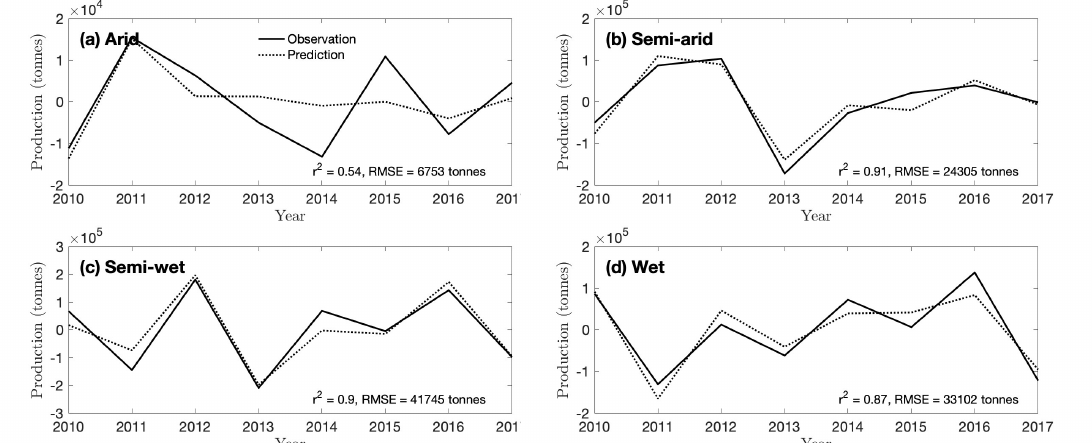
Figure 5. Observations and predictions of rice production anomalies (tonnes) in the ( a ) arid, ( b ) semi- arid, ( c ) semi-wet, and ( d ) wet climate-zones. Note that the y-axis of each subplot has a different scale. Anomalies in production are computed as a deviation from a least-squares fit linear trend (see Table 1 for the average total production in each region). Predictions are made using the optimal (cid:48) growing season length (SM C4 ) following Equation (1). Observations are plotted with a solid line and predictions with a dotted line. See Figures S12–S14 for analogous plots for maize, cassava, and sweet